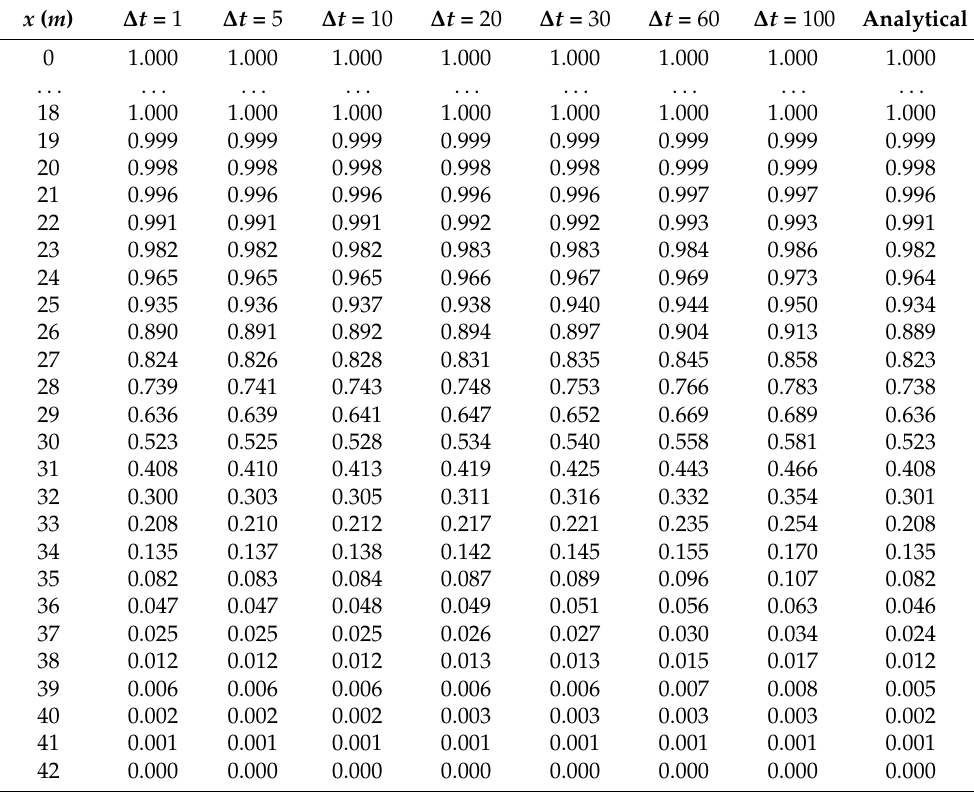
Table 2. Comparison of the analytical solution with the numerical results of the ERK4-NCCD scheme for different time steps ∆ t at t = 3000